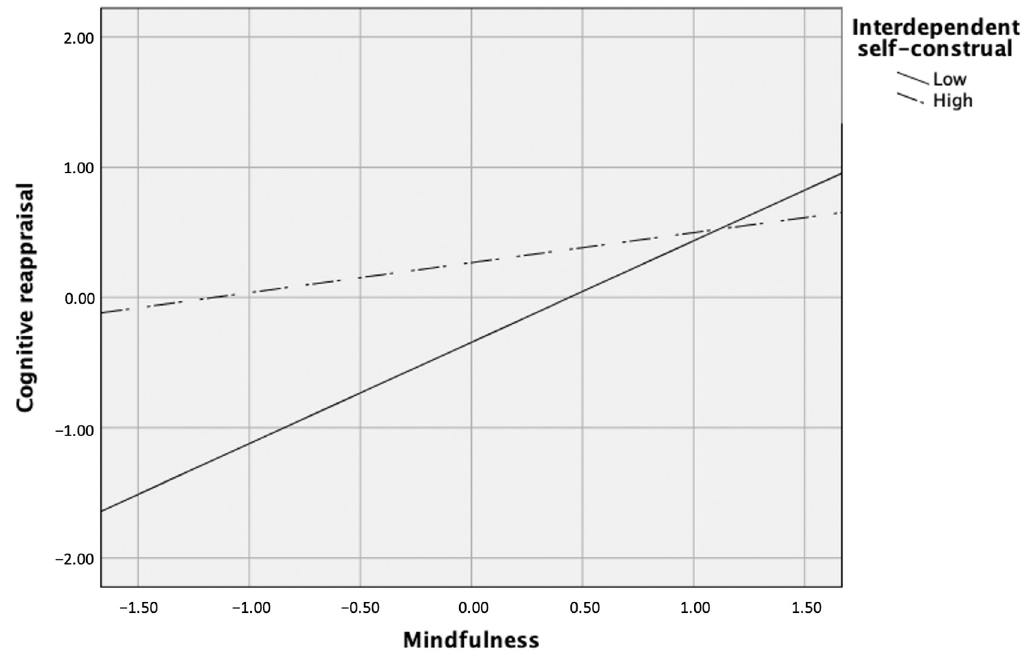
Figure 2. Interdependent self-construal as a moderator between mindfulness and cognitive reappraisal.